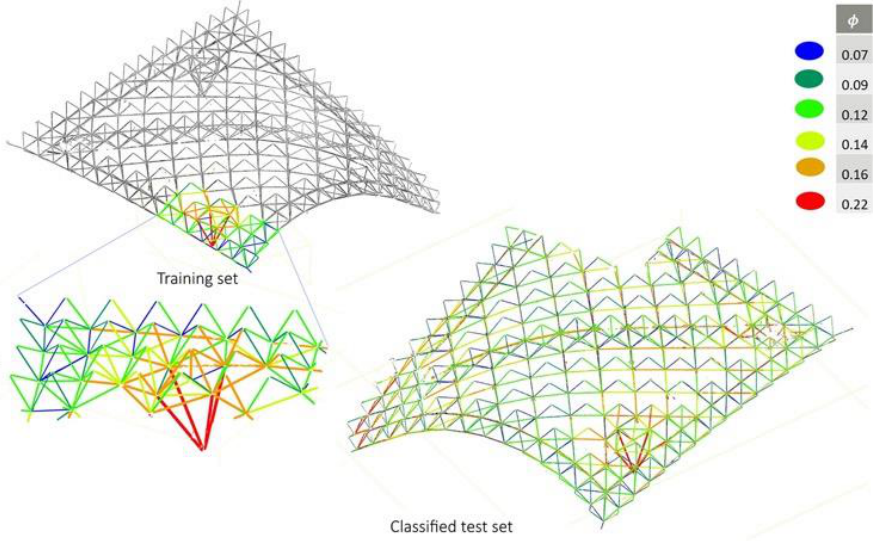
Figure 19. Training set and classification results at the third classification level: Classes 12 and 13.